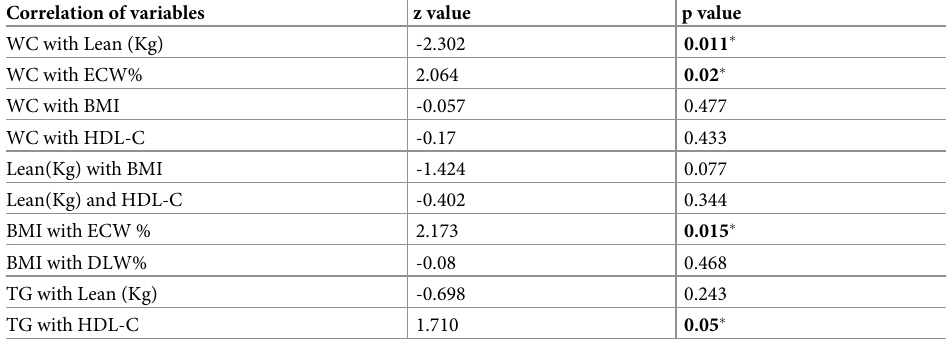
Table 4. Comparison of correlation coefficients of anthropometric measurements, body composition parameters and lipid profile between PD and control groups. Correlation of variables